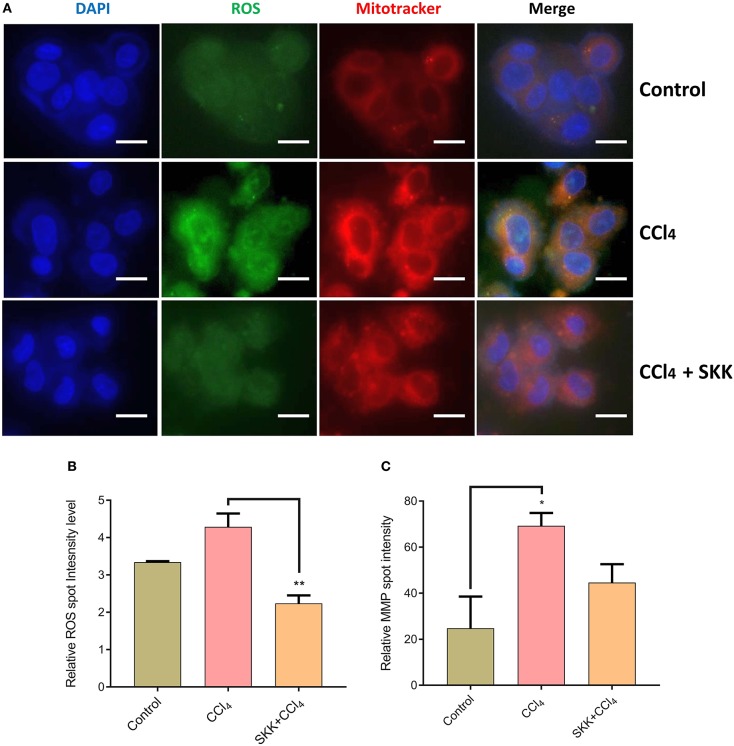
Reactive oxygen species and mitochondrial membrane potential measurement in Divya Sarva-Kalp-Kwath (SKK) and carbon tetrachloride (CCl4) treated HepG2 cells: (A) Oxidative stress was induced in the HepG2 cells following stimulation with the CCl4. Intracellular presence of reactive oxygen species (ROS; green color) and an increase in mitochondrial membrane potential (MMP; red color) were determined through epifluorescence microscope based imaging and HCS Studio software based analysis. Co-treatment of the HepG2 cells with SKK and CCl4 significantly reduced the production of ROS and MMP. (B) Quantitatively, ROS levels in the CCl4 stimulated HepG2 cells showed an upregulation. (C) Similarly, MMP in the CCl4 stimulated HepG2 cells showed an upregulation. Both these parameters showed a reduction following the co-treatment of the HepG2 cells with CCl4 and SKK. Results are expressed as Mean ± Standard Error of Means. One-way analysis of variance (ANOVA) followed by Dunnett's multiple comparison t-test was used to calculate the statistical difference. p-value *<0.05; **<0.01. Bars represent 200 μm.